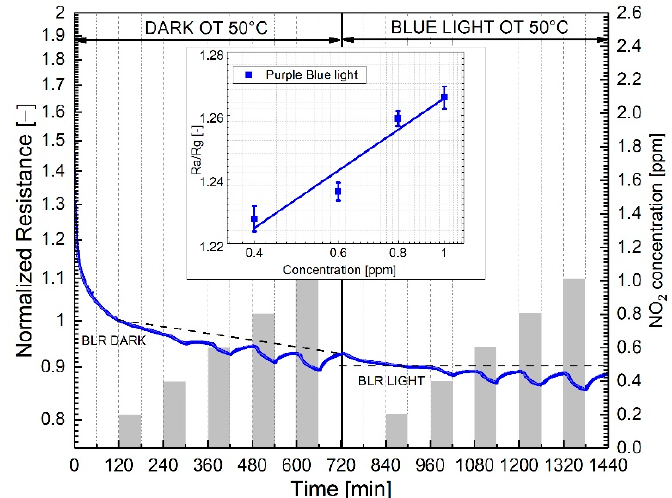
Figure 8. Comparison of WS 2 -decorated rGO’s electrical responses to increasing NO 2 concentrations at 50 °C operating temperature under dark and light conditions respectively. The inset shows the sensitivity plot corresponding to light conditions. The bars in the inset represent the standard deviation calculated over a set of five measurements performed for each gas concentration. Dotted lines indicate the baseline resistance in dry air.